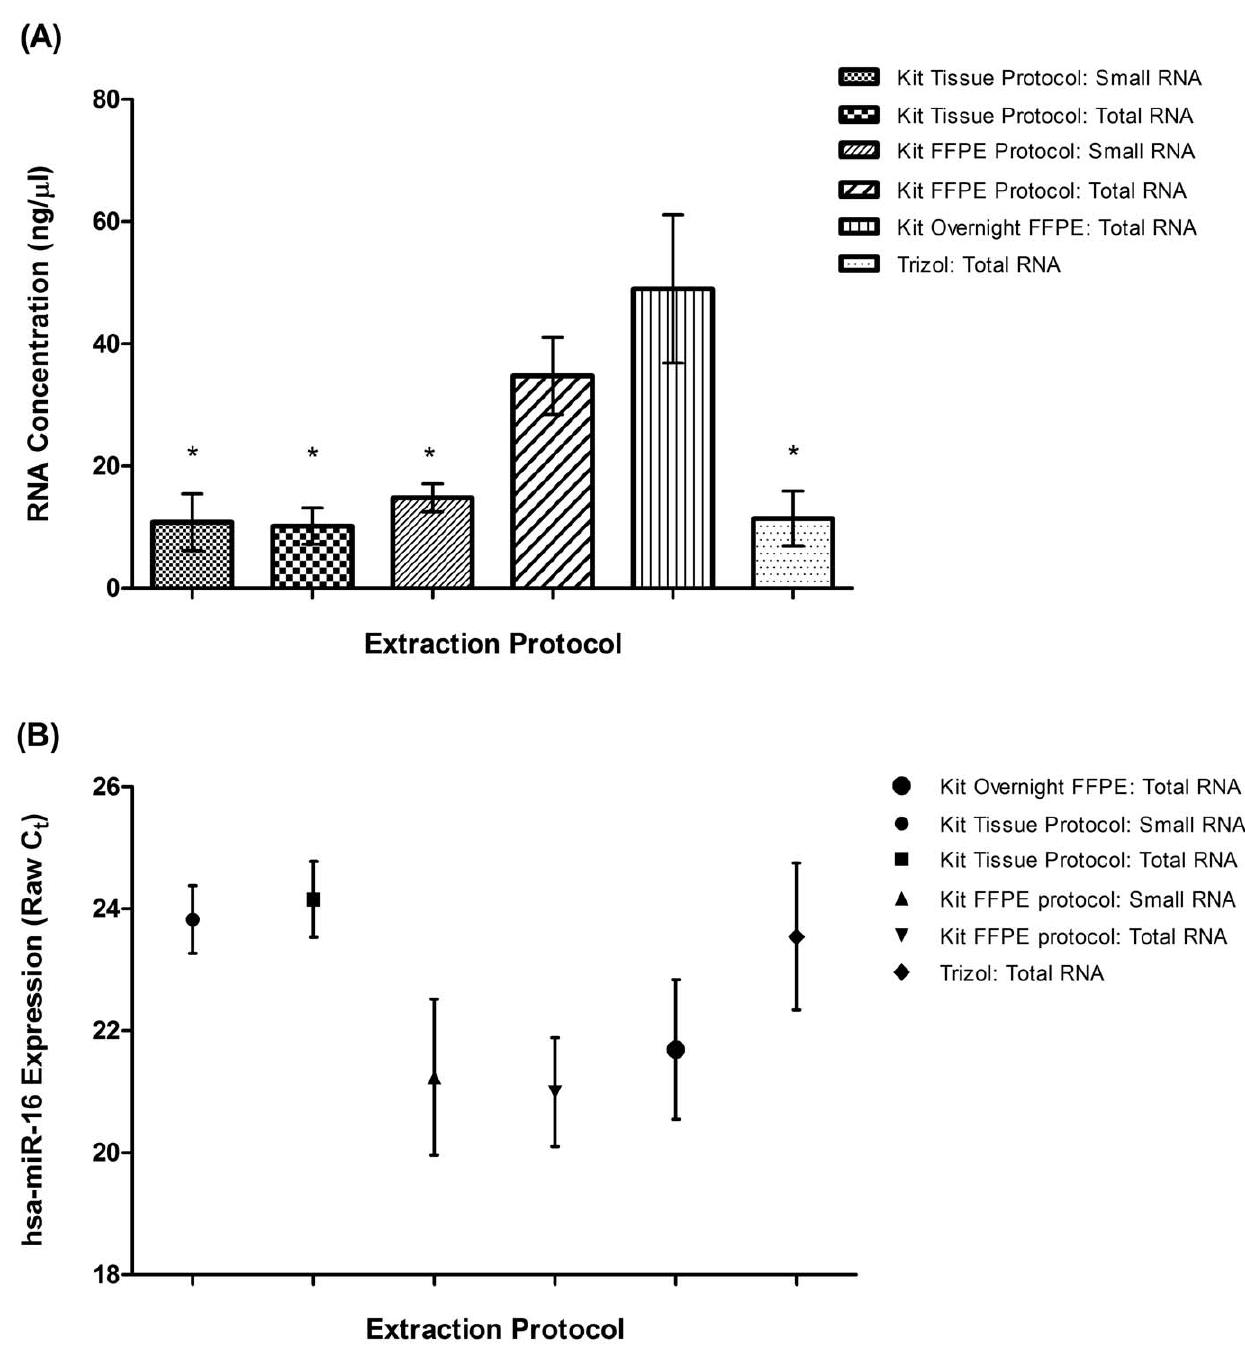
Figure 2. A comparison of RNA extraction methods for the evaluation of RNA concentration (ng/ m l) and miRNA expression from archived bone marrow aspirate slides. The comparison of miRNA extraction methods from matched unstained archived bone marrow smears (n=6 or n=8 patients; Table S3). Six different methods were used based on traditional TRIzol or using the Roche High Pure miRNA Column extraction kit (Table 1). ( A ) Comparison of Total RNA yield from experimental extraction protocols . The average RNA concentration was measured by NanoDrop (ng/ m l 6 s.e.m.). Kit Total RNA extraction methods with a Proteinase K digestion (‘FFPE protocol’) are higher in RNA yield compared to kit methods without a digestion step (‘Tissue protocol’), or when extracting small RNA only. These methods are also significantly better than TRIzol extractions. The archived slide extraction method with the highest RNA yield was the Roche kit ‘isolation from FFPE Tissue’ Total RNA extraction with an overnight Proteinase K digestion. * Indicates RNA concentration is significantly different to the Kit Overnight FFPE: Total RNA protocol. ( B ) Comparison of hsa-miR-16 expression from experimental extraction protocols . The average expression of our reverence gene (hsa-miR-16) measured by qRT-PCR (raw C t 6 s.e.m.). Raw C t value tracks with total RNA yield, whereby as the concentration of RNA increases the C t value decreases. This analysis shows extractions with a Proteinase K digestion return a lower C t value compared to extractions without a digestion step. TRIzol extractions also return a higher C t value than the Proteinase K digestion protocols.